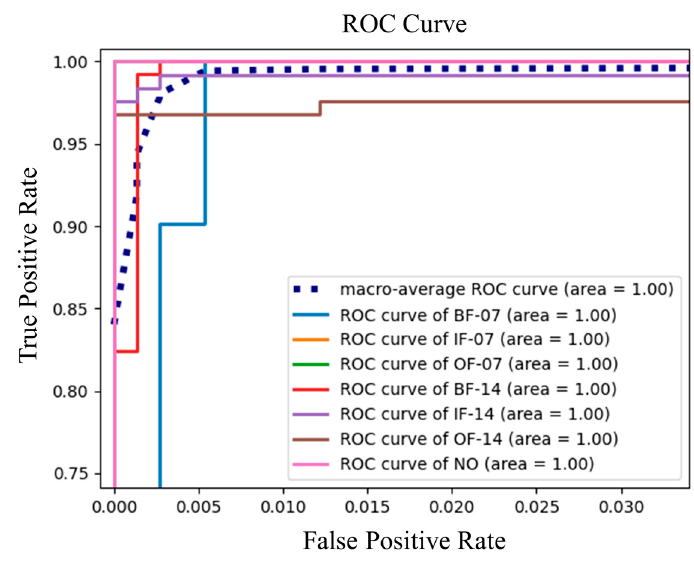
Figure 13. The ROC curve of fault diagnosis result.